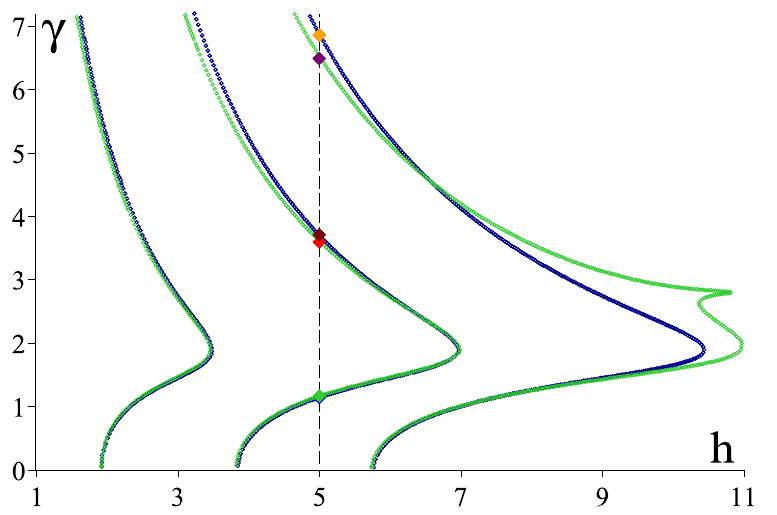
β α (green curve) P 1.141 ≈ and propagation constants P α β α